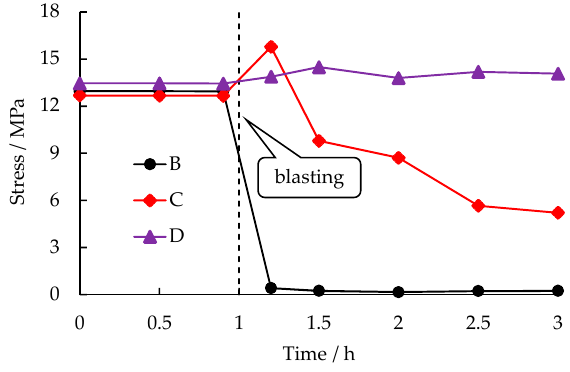
Figure 6. Variation in stress exerted on the coal body at different positions from blasting.